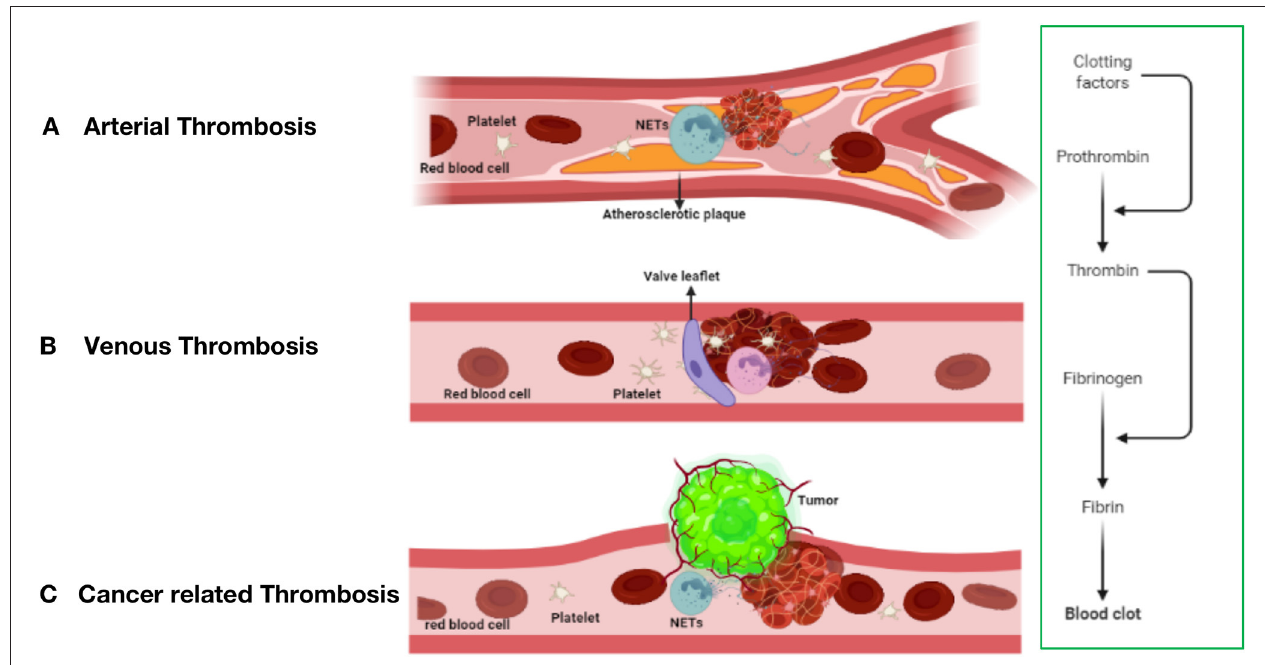
FIGURE 2 | The mechanism of thrombosis formation in arterial thrombosis (A) , venous thrombosis (B) , and cancer-related thrombosis (C)